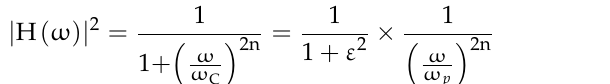
Table 1. Statistics of wind speeds and HFR residual surface vector speeds.